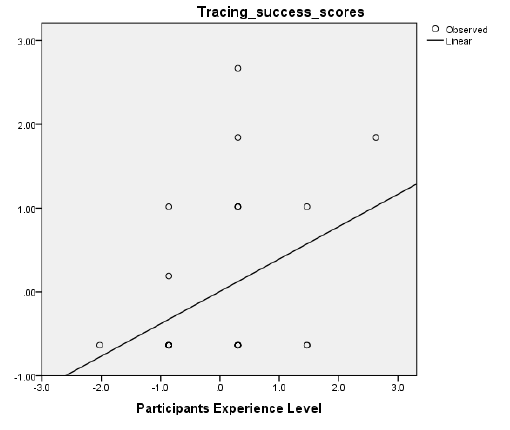
Figure 8. Tracing success.